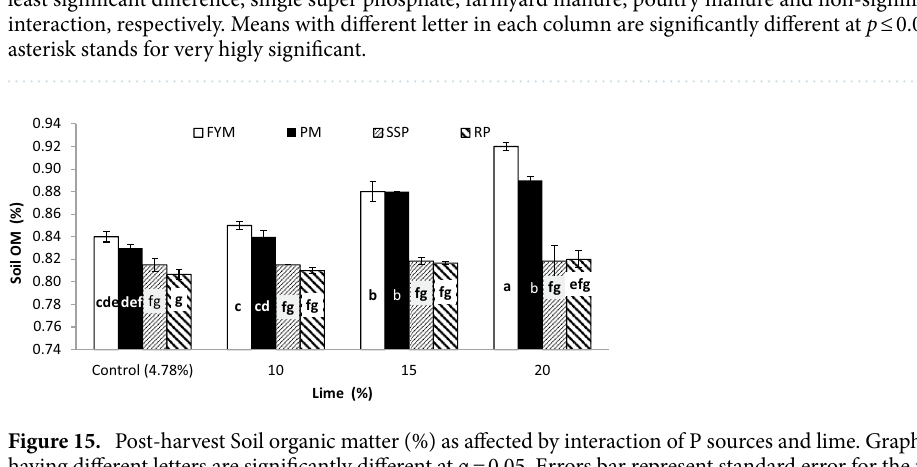
Table 6. There was no statistical difference between inoculated and un-inoculated pots for post-harvest soil EC, pH and lime while, SOM was significantly decreased by about 0.83% in inoculated treatments over control. Simi- larly, P sources didn’t affect soil EC and lime. A significant decrease in soil pH was observed with the application of organic sources (PM and FYM), however, their effect was not statistically different from SSP. The highest pH was observed at RP which was also similar to SSP. Significant increase in after harvest SOM was observed with addition of P as FYM which was higher than PM and the lowest SOM was observed where P was supplemented through SSP and RP. Liming significantly augmented post-harvest soil EC, pH, SOM and lime content (Table 6). With increasing lime application, all mentioned attributes were gradually increased. Liming increased post- harvest soil EC by 42, 82 and 111, pH by 3, 5 and 6, SOM by 1, 3 and 5 and lime 106,210 and 314% over control (4.78%) at 10, 15 and 20% lime, respectively. None of the interactions were significant for post-harvest soil EC, pH, SOM and lime except lime and P sources (L × PS) which significantly altered post-harvest SOM (Fig. 15). Addition of lime didn’t affect SOM in pots treated with SSP and RP. Pots where P was applied as organic sources like PM and FYM, SOM significantly varied with liming. Maximum SOM was recorded for FYM at 20% lime followed by PM at 20 and 15% which